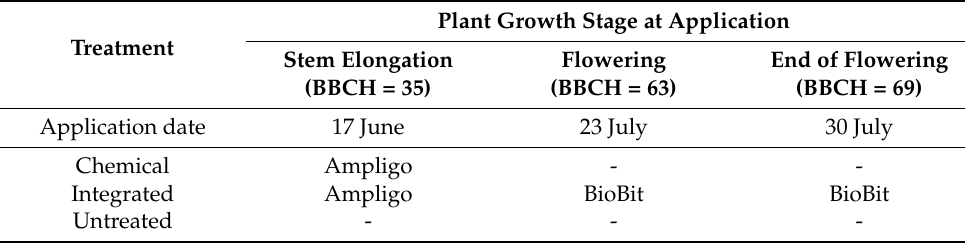
Table 2. Insecticidal products applied in experiment 3 for each thesis